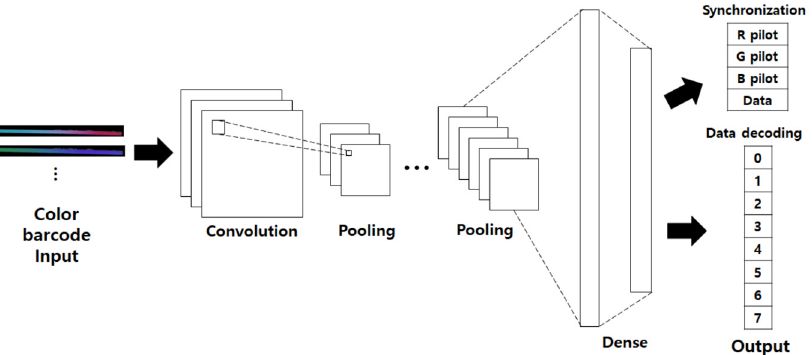
Figure 9. The CNN model’s structure for packet synchronization and data decoding.